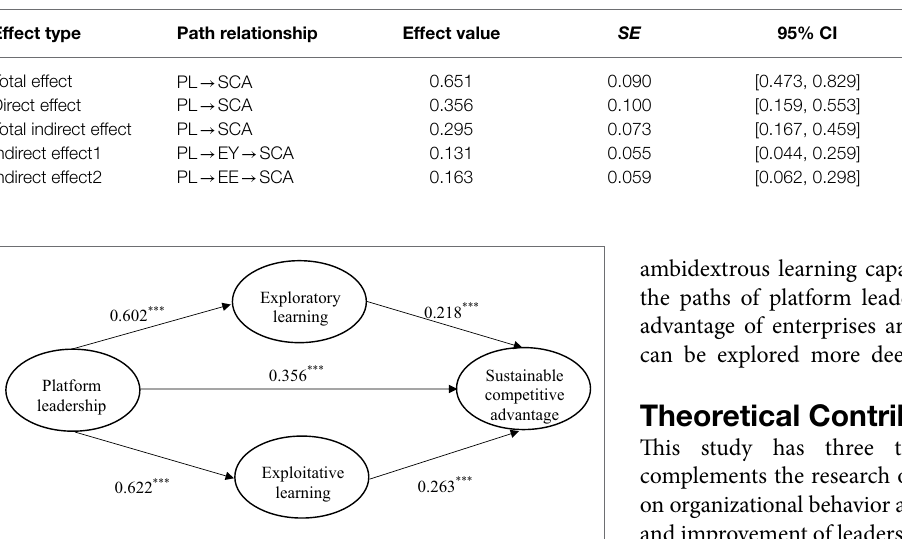
FIGURE 2 | Hypotheses testing. *** p ≤